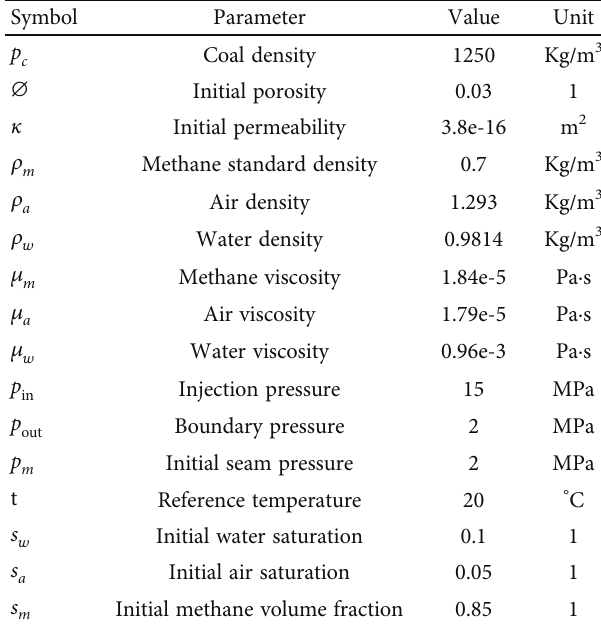
Table 1: Coal seam